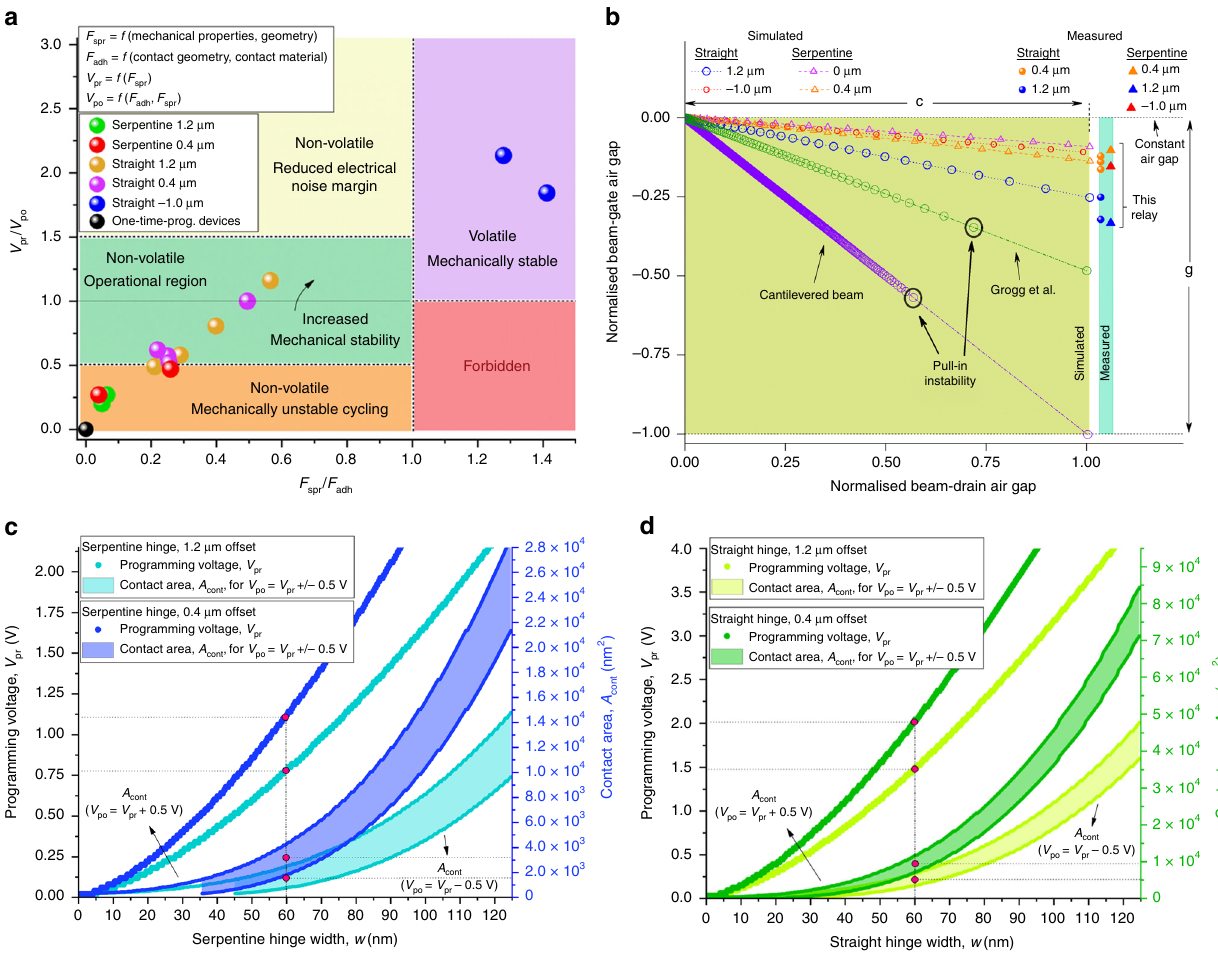
Fig. 3 Regimes of operation and scaling study. a Operating regimes of NEM relays for serpentine and straight hinges. The condition F adh = F spr separates the regions where the device is volatile or non-volatile, while V pr = V po separates the regions where the applied reprogramming voltage causes the device to be overdriven or not. The plot is populated with data points measured in ambient air, room temperature experiments showing NEM relays operating in each regime. b Comparison with prior art of uniformity of beam-to-gate airgap g vs. beam-to-drain airgap c as the relay moves, based on fi nite-element simulations. The beam-to-gate airgap of the moment-driven relay has under 6% variation for small and negative hinge offsets for the entire range of operation. In contrast, the beam-to-gate airgap decreases by nearly 100% at the beam tip in straight cantilever, bridge, see-saw and crab leg relay architectures unless restricted by the contact dimple. The curved beam relay reported by Grogg et al. 11 experiences a ~50% reduction in the airgap at contact. The simulation plot also shows the proposed NEM relay does not exhibit pull-in instability. The measured beam-to-gate displacements after actuation were obtained from SEM scans of the device after beam rotation. This experimental data is plotted on the right. c , d Scaling study showing variation of programming voltage (i.e. voltage required for closure from a neutral state) with hinge width for actuation and contact airgaps of 60 nm, and contact area needed to achieve a reprogramming voltage within 0.5 V of the programming